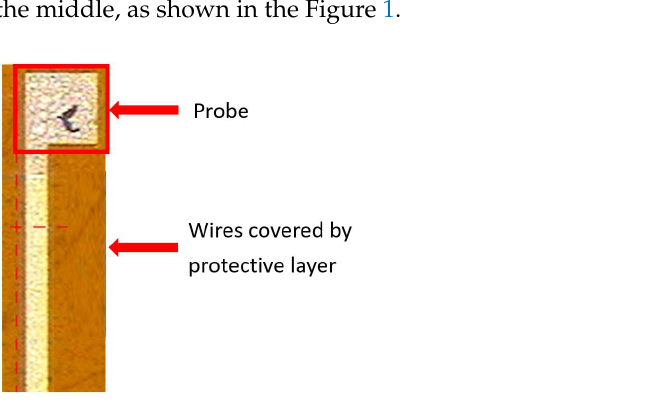
Figure 1. Schematic diagram of voltage and current microsensor.